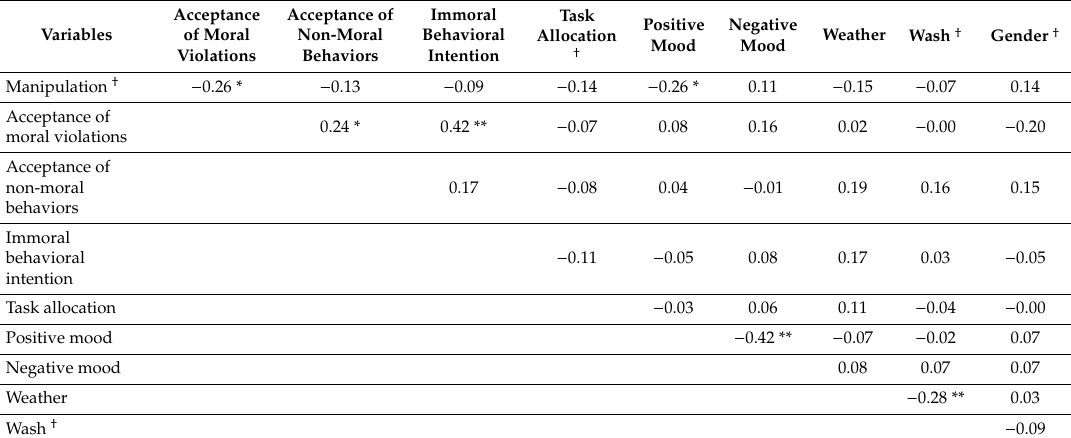
Table 3. The correlations of variables used in Study